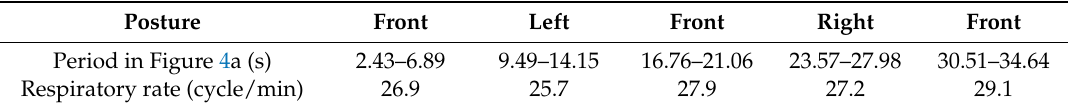
Table 4. Average respiratory rate during exercise (shown in Figure 4). Bending the upper body forward and backward.